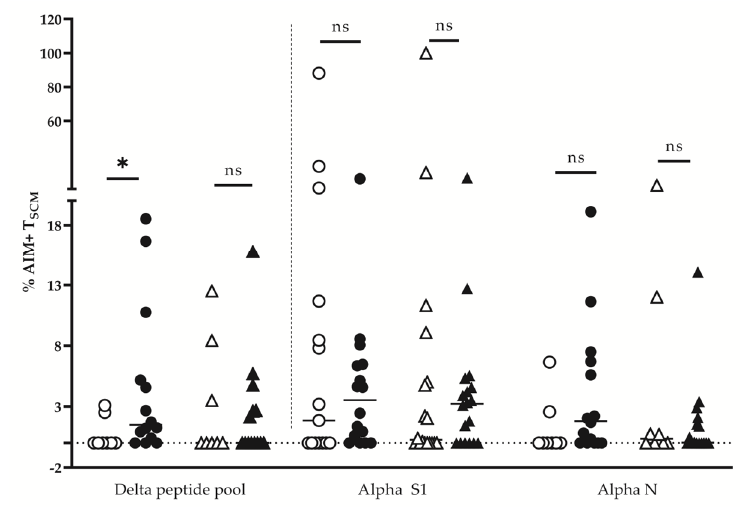
Figure 6. Effect of the priming variant on the proportions of T SCM . The proportions of CD4+ (circles) and CD8+ (triangles) SARS-CoV-2 specific T SCM among all T SCM (CD45RA+CD197+CD27+CD95+) in donors primed with alpha variant (open symbols) and in donors primed with delta variant (black symbols) were compared after stimulation with Delta peptides (left part) or S1 and N peptides (right part). Statistical significance was determined by the Mann-Whitney test (* p < 0.05; ns, not significant).